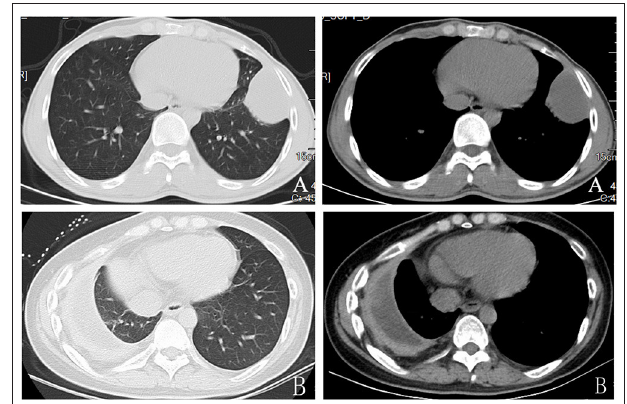
FIGURE 1 | Preoperative computed tomographic scan showing thickened parietal and visceral pleura with collection.Stage II ertuberculosis empyema (A) and stage III tuberculosis empyema (B)